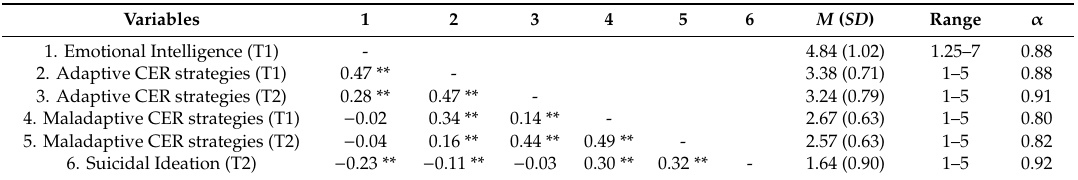
Table 3. Descriptive statistics of the Study